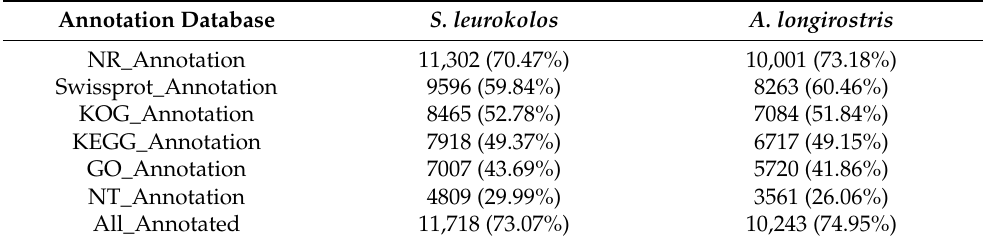
Table 2. Summary of unigene annotation with different